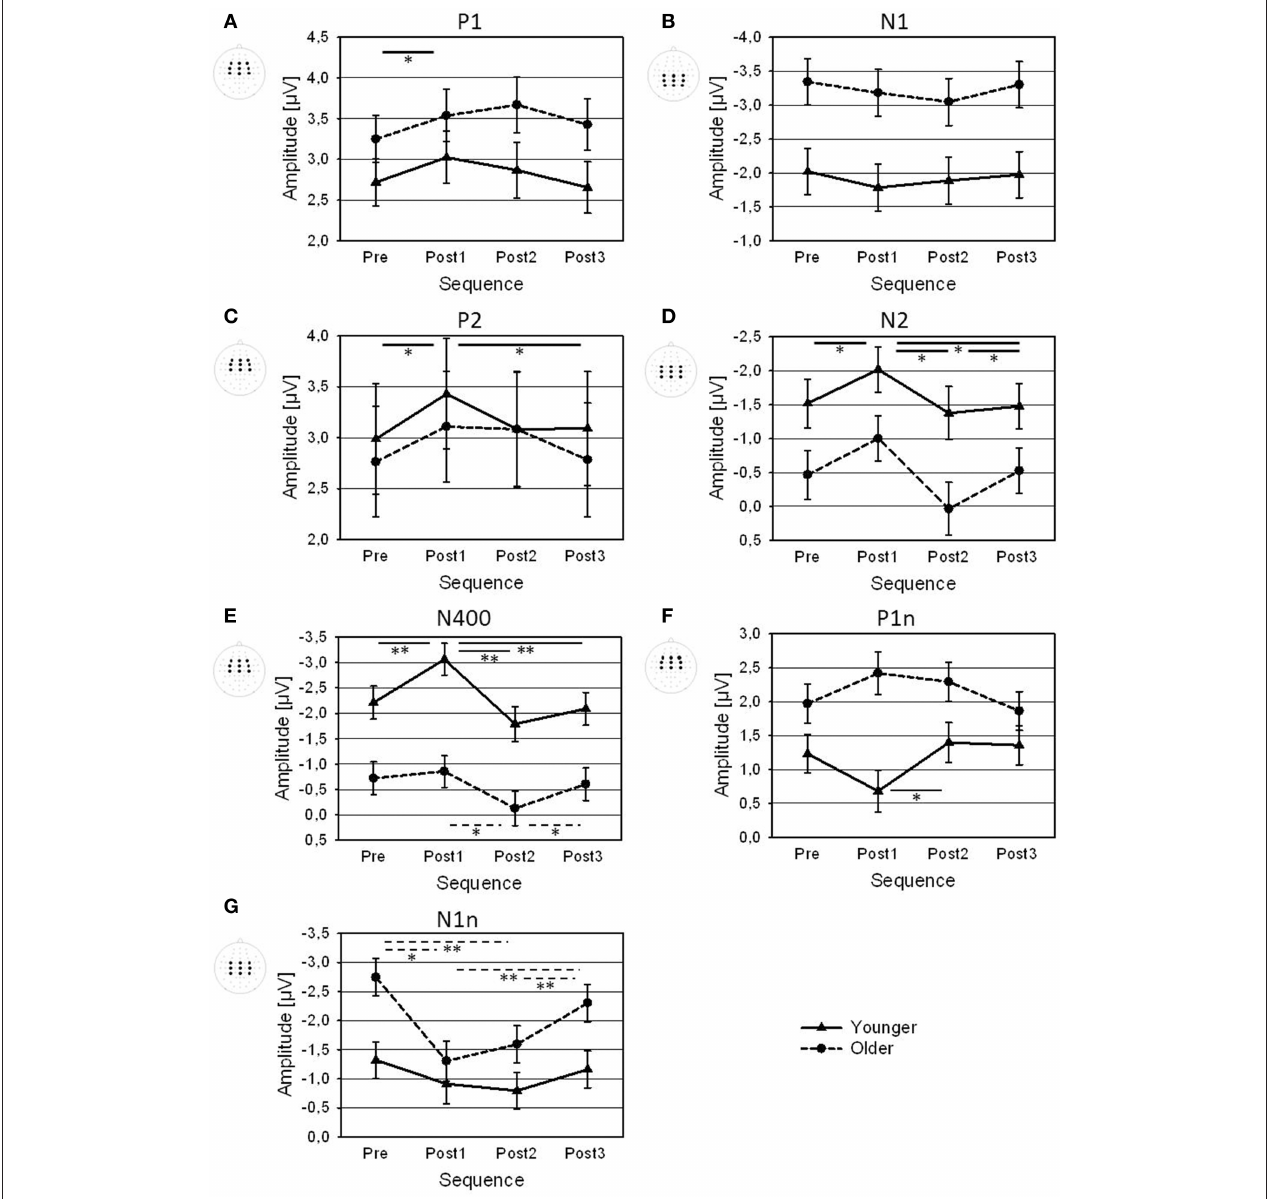
FIGURE 4 | Amplitudes of (A) P1, (B) N1, (C) P2, (D) N2, (E) N400, (F) P1n, and (G) N1n (averaged across the displayed electrode arrays) for Pre, Post1, Post2, and Post3 sequences, shown for younger and older participants. Error bars are standard errors across participants ( N = 22 ). Significance bars and asterisks indicate significant differences between sequences in the younger group (solid), in the older group (dotted), or averaged across both groups (bold; * p < 0.05 ; ** p < 0.01 ).